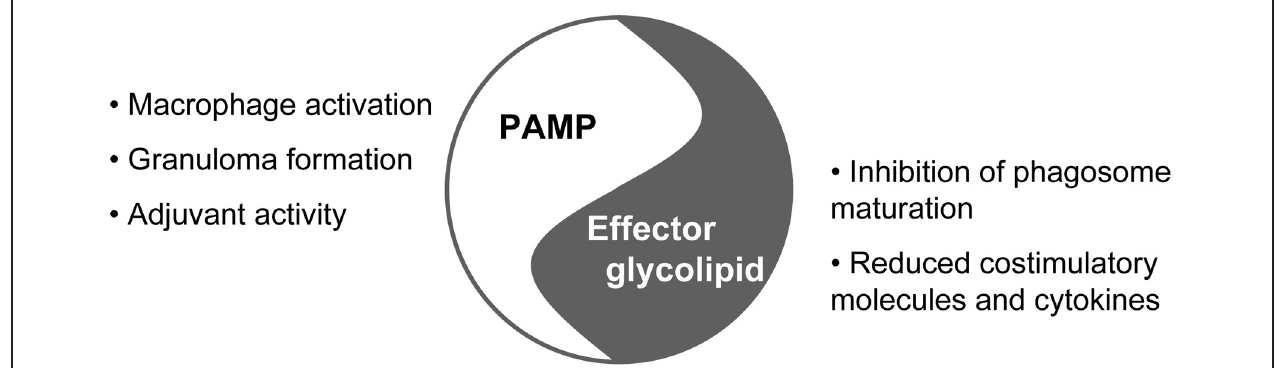
FIGURE 1 | TDM between PAMP and effector